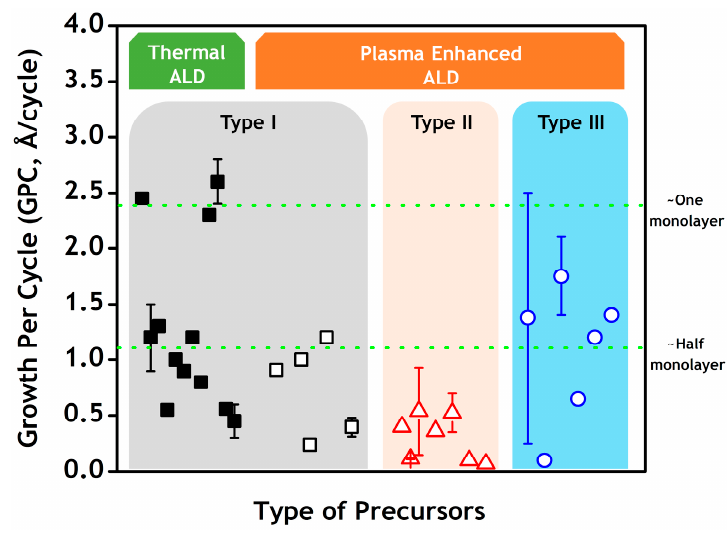
Figure 2. Plot of SiN x ALD growth per cycle (GPC) data (from Tables 1 and 2) vs. different types of silicon precursors using thermal ALD (solid symbol) and plasma-enhanced ALD (open symbol).